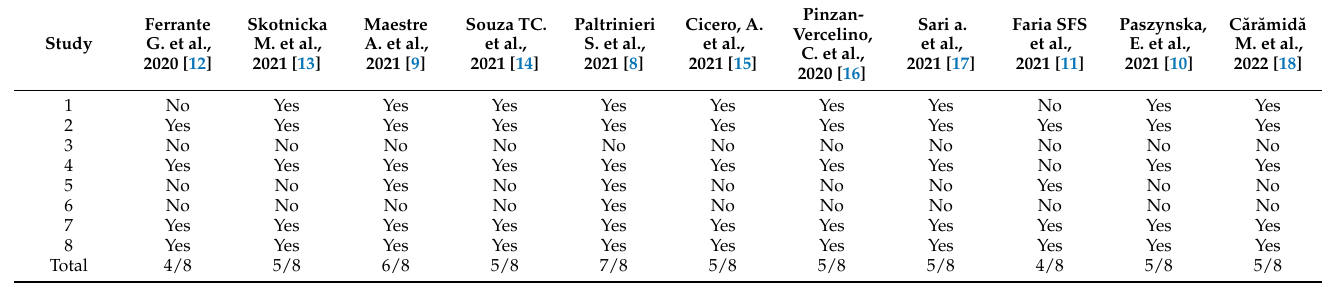
Table 2. Analysis of articles based on JBI Critical Appraisal Checklist for Analytical Cross- Sectional